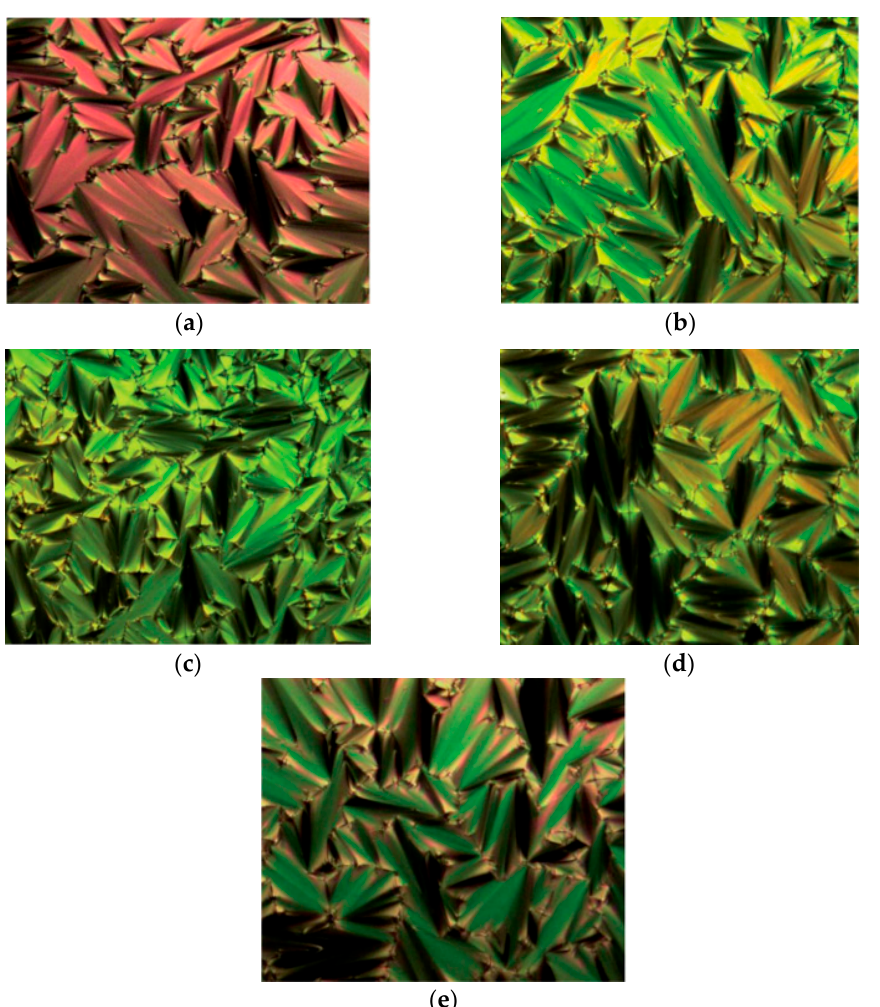
Figure 12. The optical photomicrograph of SmA phase for compound 11a–e , ( a ) compound 11a at 270.55 °C, ( b ) compound 11b at 268.77 °C, ( c ) compound 11c at 268.50 °C, ( d ) compound 11d at 255.43 °C, and ( e ) compound 11e at 247.78 °C. Reprinted/adapted with permission from Ref. [47]; published by Royal Society of Chemistry, 2020.